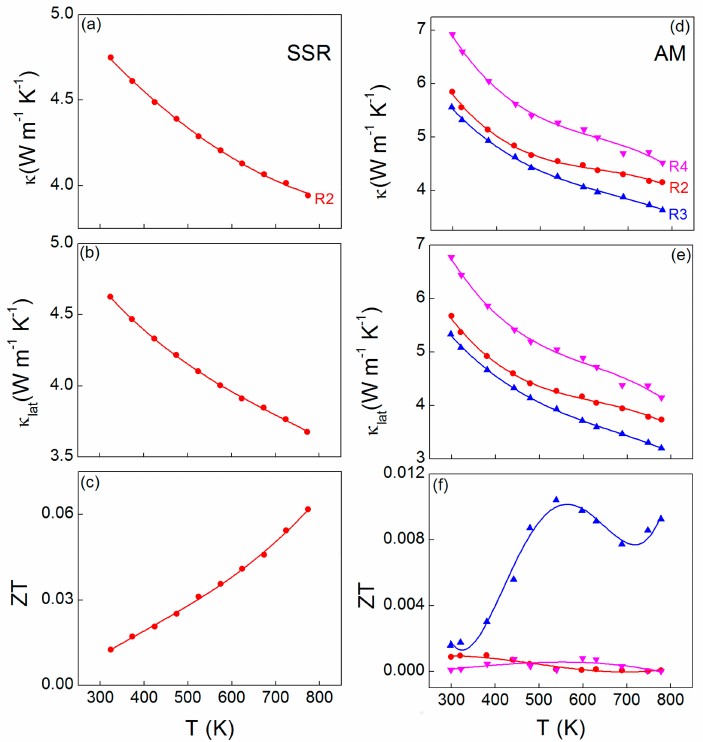
Figure 4. Temperature dependence of the total thermal conductivity ( κ ), the lattice thermal conductivity ( κ lat ), and the thermoelectric figure of merit ( ZT ) for ( a – c ) the powder route and ( d – f ) the arc-melted Ti 0.7 V 0.3 Co 0.85 Fe 0.15 Sb 0.7 Sn 0.3